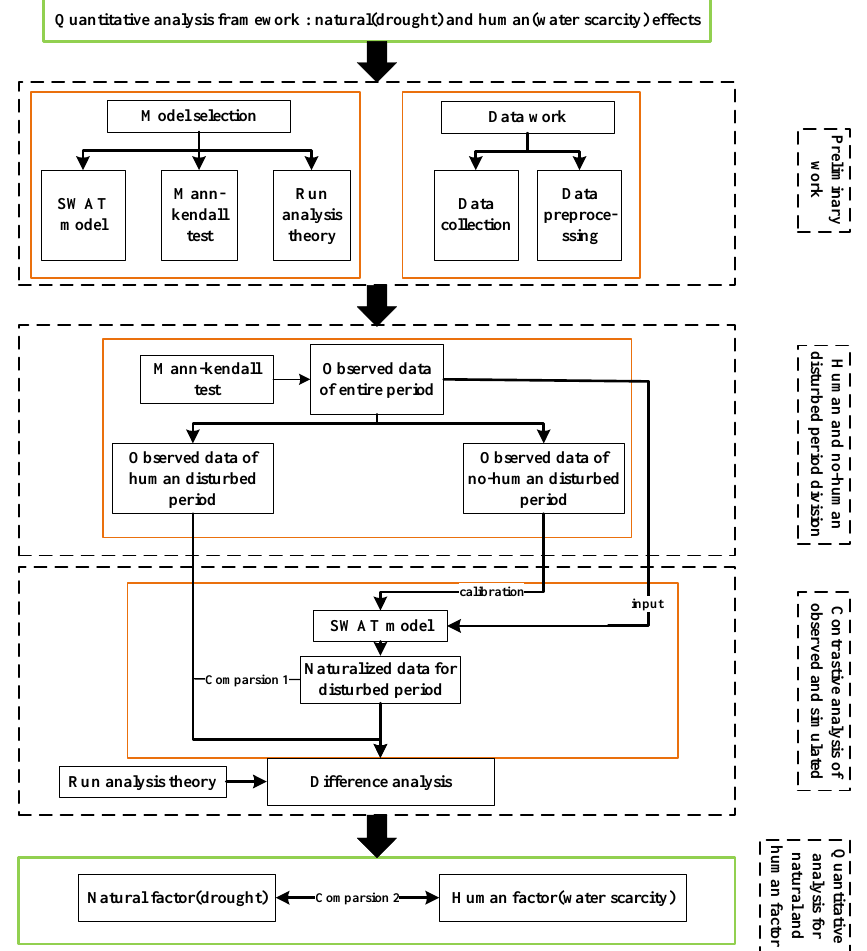
Figure 4. Technical roadmap for this study.